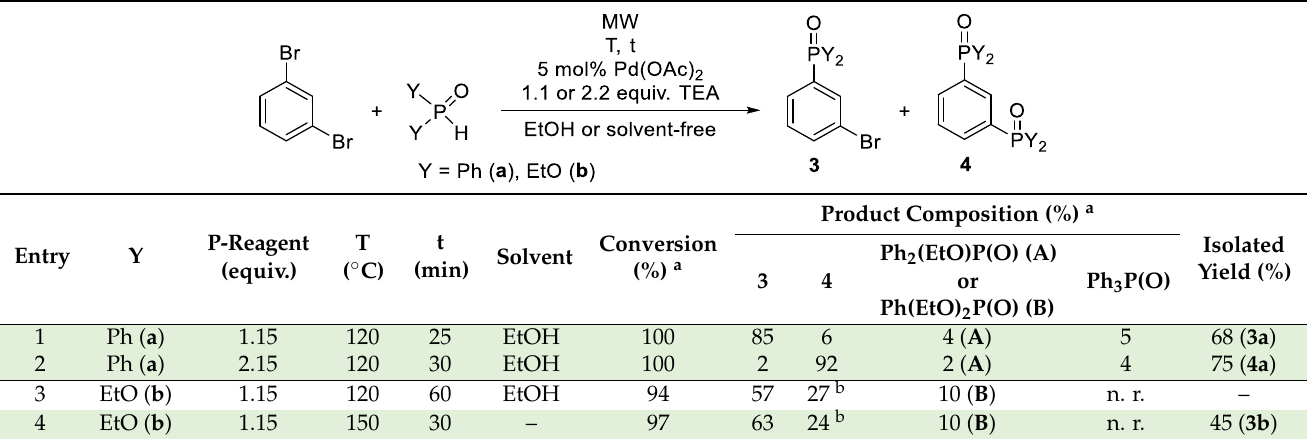
Table 4. P–C coupling reactions of 1,3-dibromobenzene. Table 4. P – C coupling reactions of 1,3-dibromobenzene.